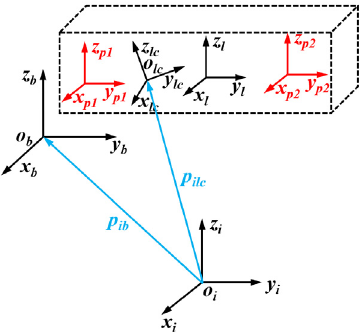
Figure 2. Schematic diagram of space station coordinates system.